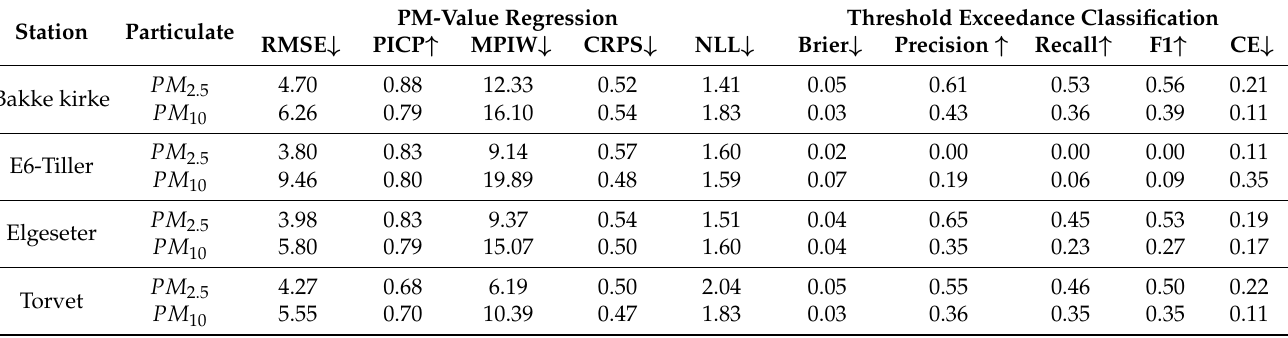
Figure 20. Predicting threshold exceedance probability of air pollutants level using a GNN model with MC dropout. Table 6. Summary of performance results when forecasting the PM-value or threshold exceedance using a GNN model with MC